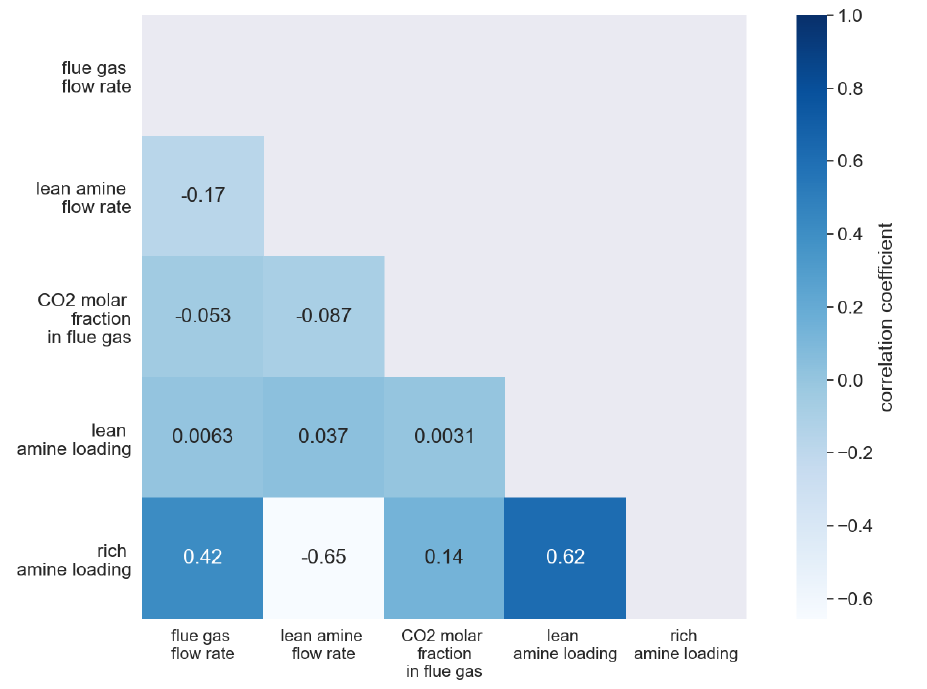
Figure 4. Plot of data correlation